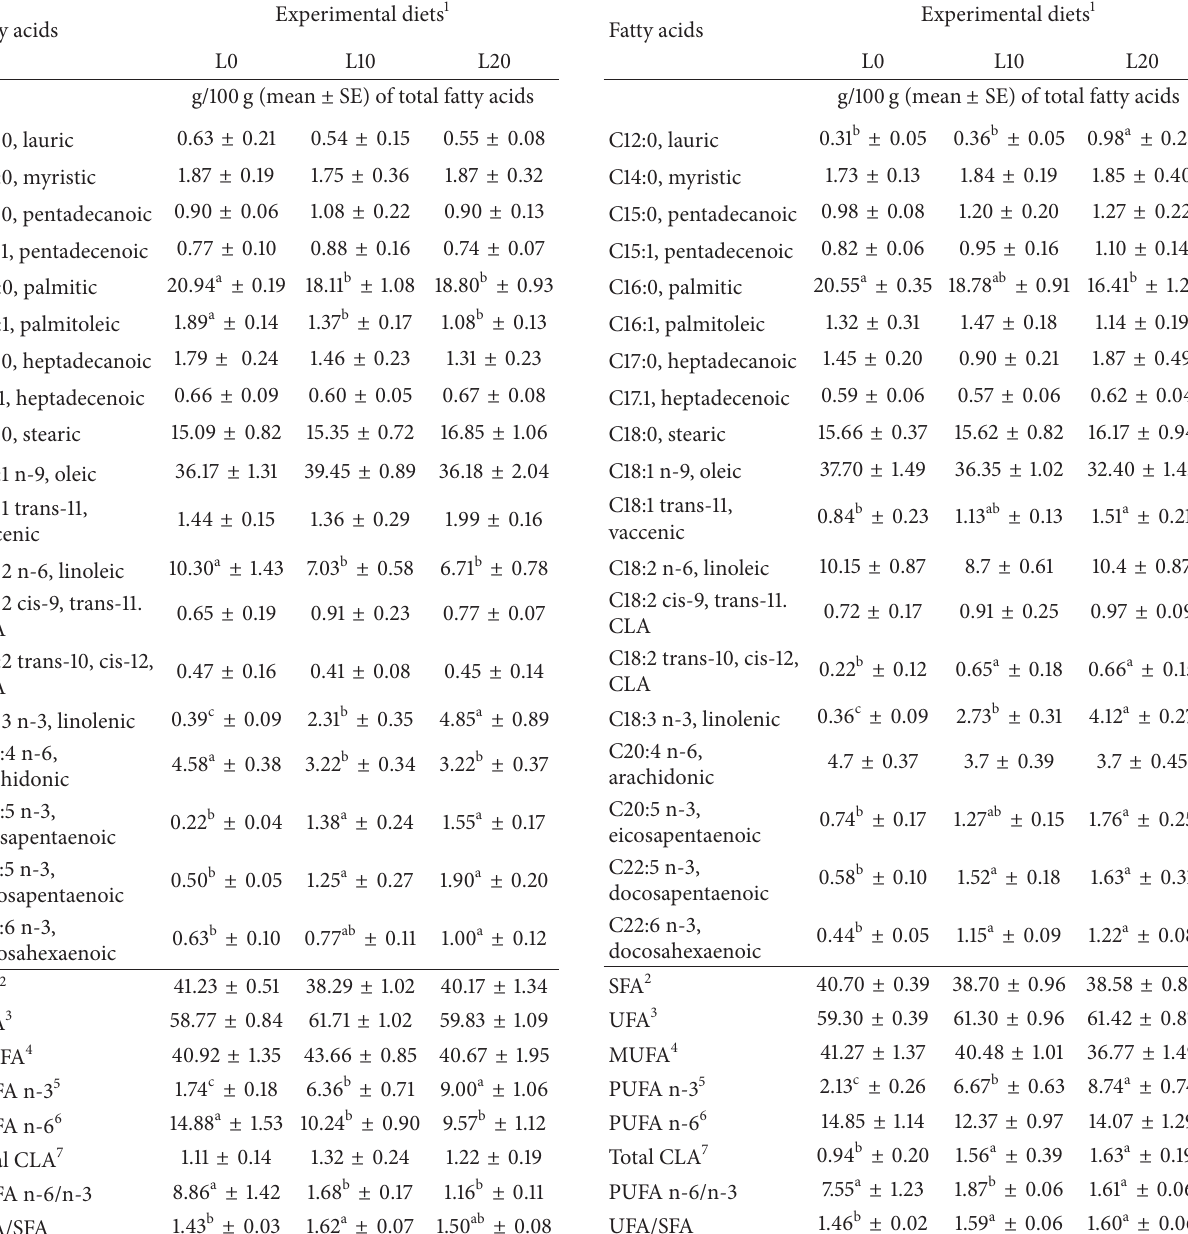
Table 3: Fatty acid profiles of the longissimus dorsi muscle of goats fed diets containing different levels of whole linseed.